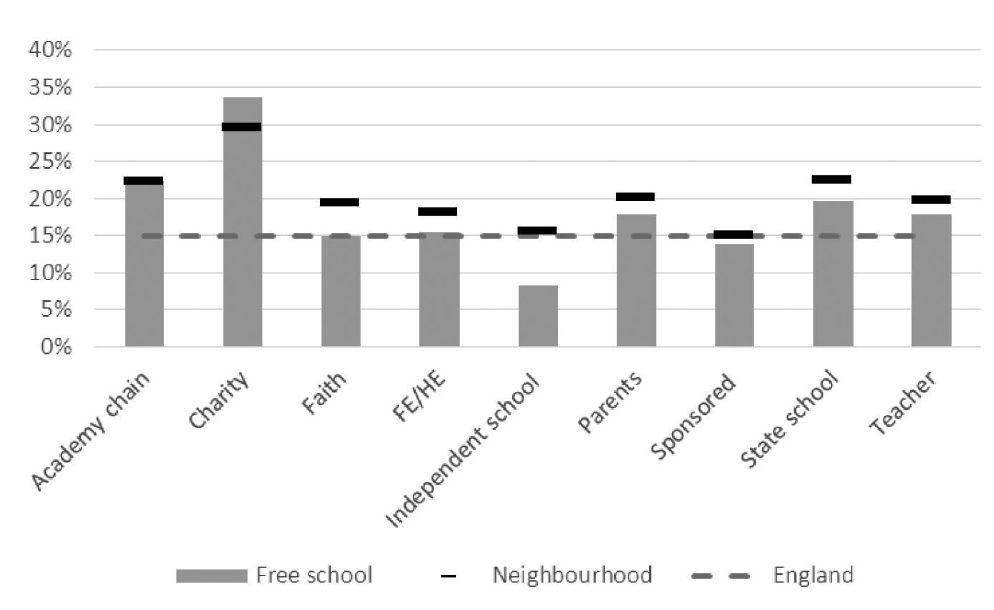
Figure 8: FSM proportions by provider category (Year 7)